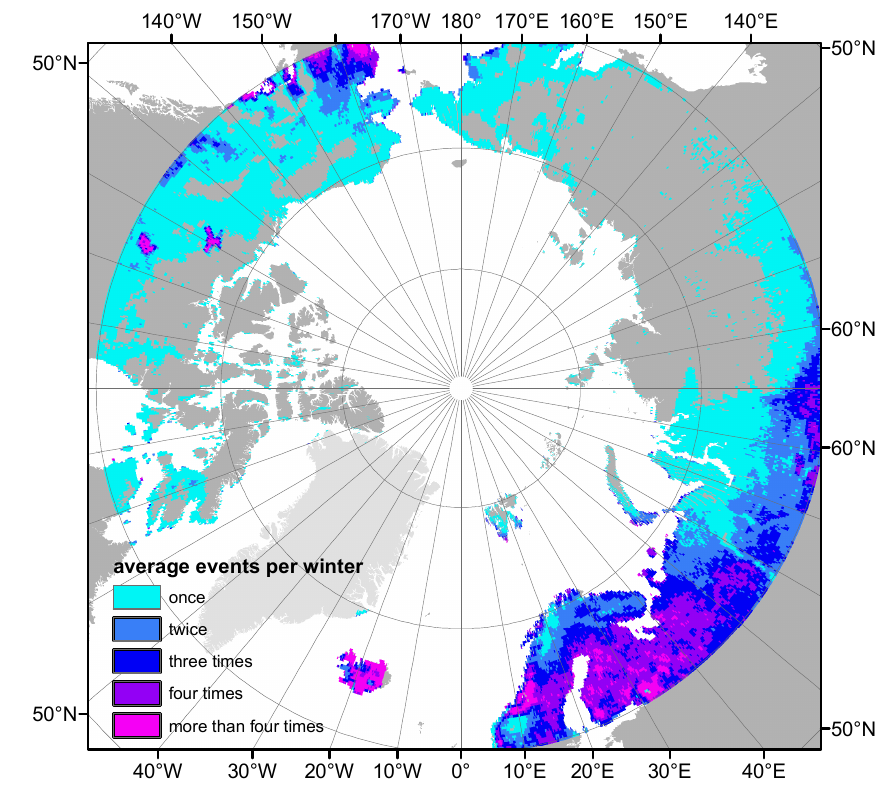
Figure 3. Frequency of midwinter daily average backscatter increases of more than 1.5 dB as detected with Ku-band QuikSCAT for the months November to February of winter 2000/1–2008/9 (no masking applied for